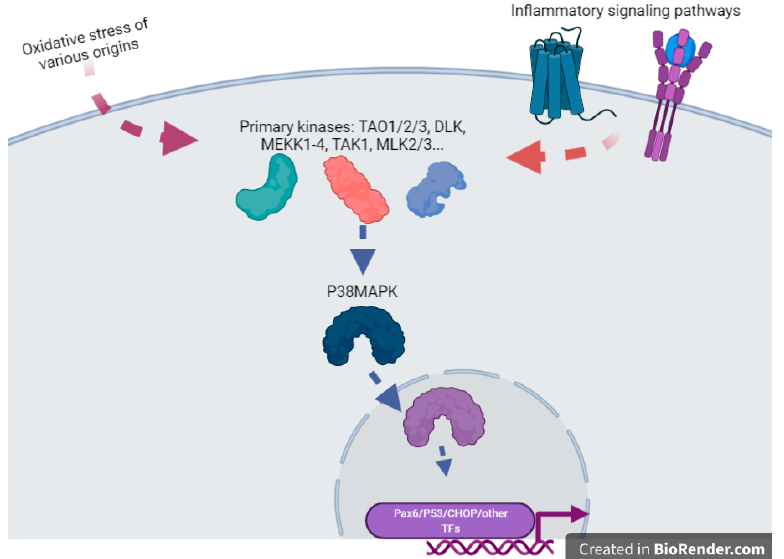
Figure 2. A cartoon emphasizing the pivotal role of P38MAPK(MAPK11) in the sensing of OS and the direct or indirect activation of various transcription factors. This is an oversimplification since this factor, once inside the nucleus, can also modulate chromatin structure through action upon structural components of the chromatins such as HMGN1 or Histone H3. This drawing is a simplification from [89].